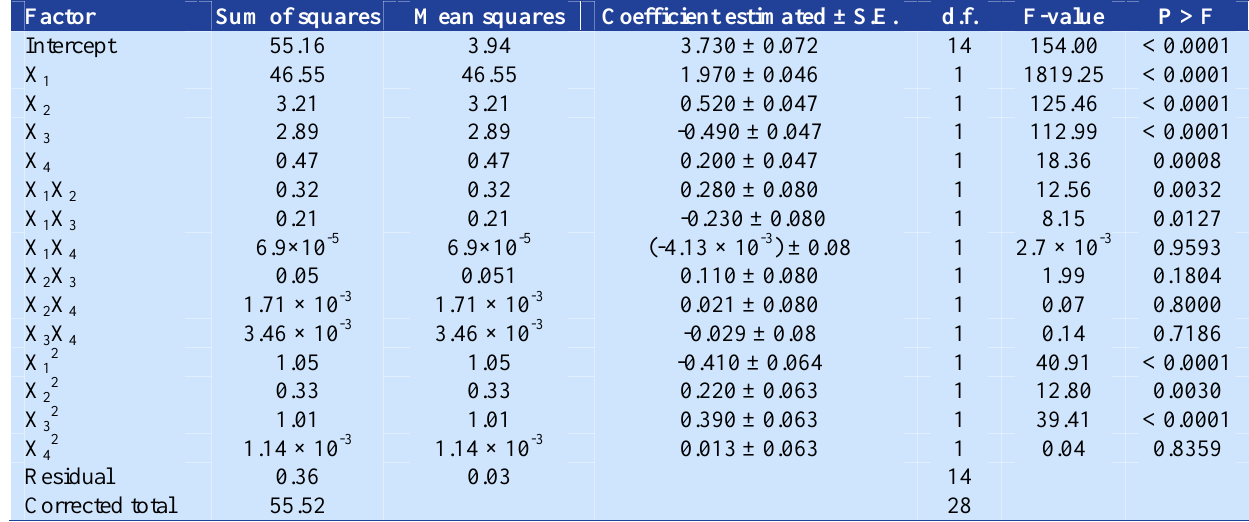
Table 2. Analysis of variance (ANOVA), regression coefficient estimate, and test of significance for humic acid (HA) removal Factor Sum of squares Mean squares Coefficient estimated ± S.E.